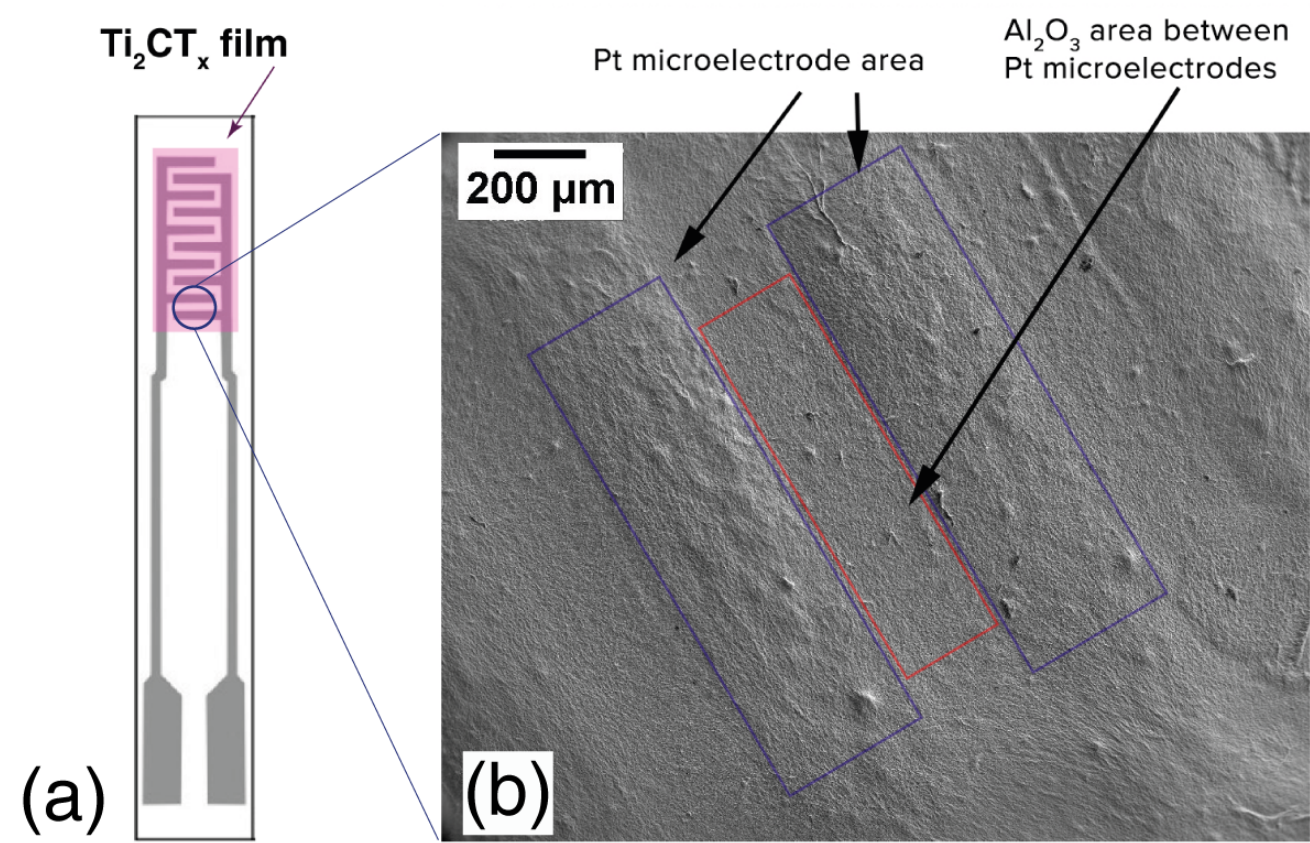
Figure 2. The scheme of an Al 2 O 3 substrate with Pt microelectrodes and Ti 2 CT x MXene film ( a ) and a microphotograph of the Ti 2 CT x film on the substrate surface with an indication of the areas where in situ Raman spectra were measured ( b ).